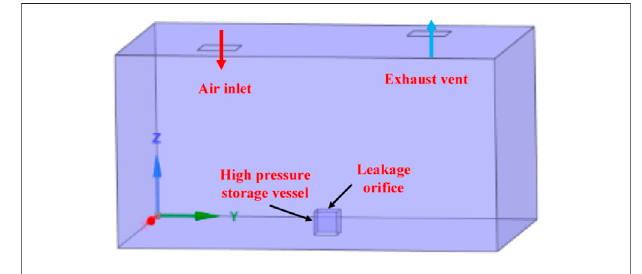
FIGURE 1 | Physical model.